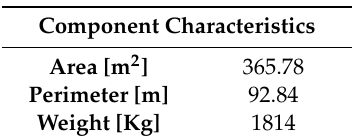
Table 2. Main geometrical features of the component under investigation.